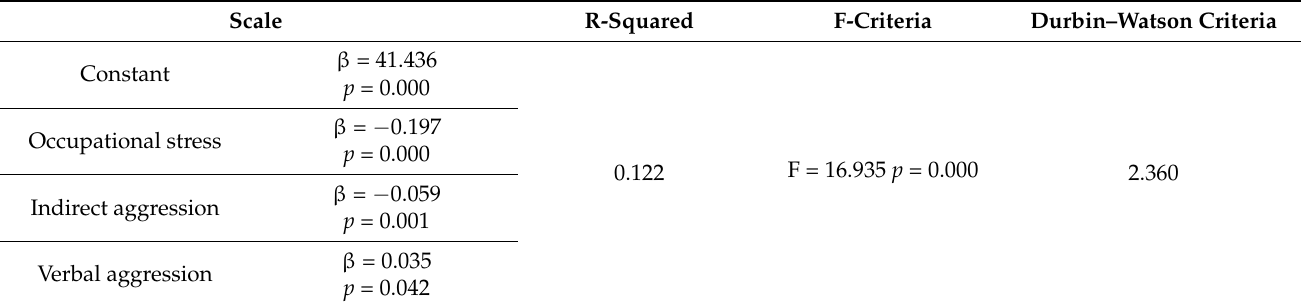
Table 9. Assessment of the contribution of occupational stress and indirect and verbal aggression to the development of reduced personal accomplishment in non-COVID-19 ICU